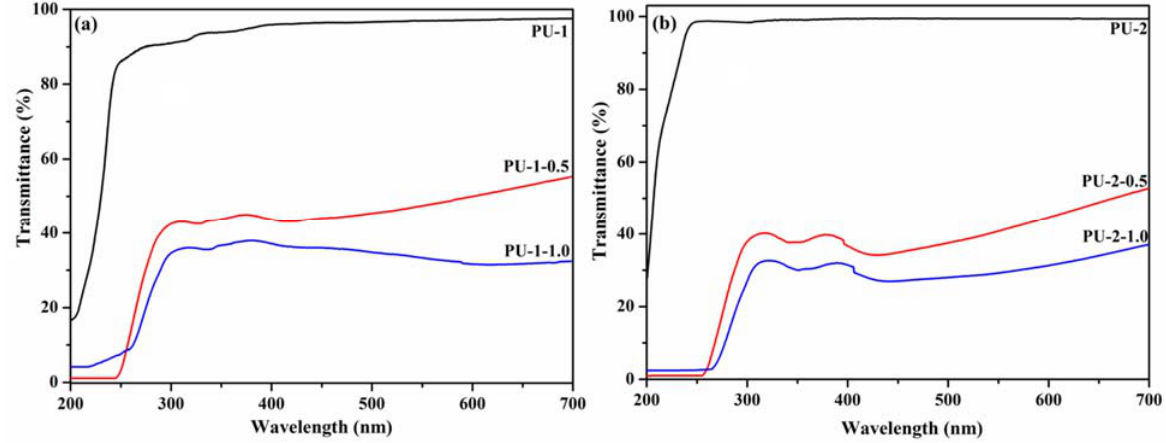
Figure 10. UV–VIS transmittance spectra of the polyurethane nanocomposite films: PU-1, PU-1-0.5 andPU-1-1.0 ( a ) and PU-2, PU-2-0.5 andPU-2-1.0 ( b ).